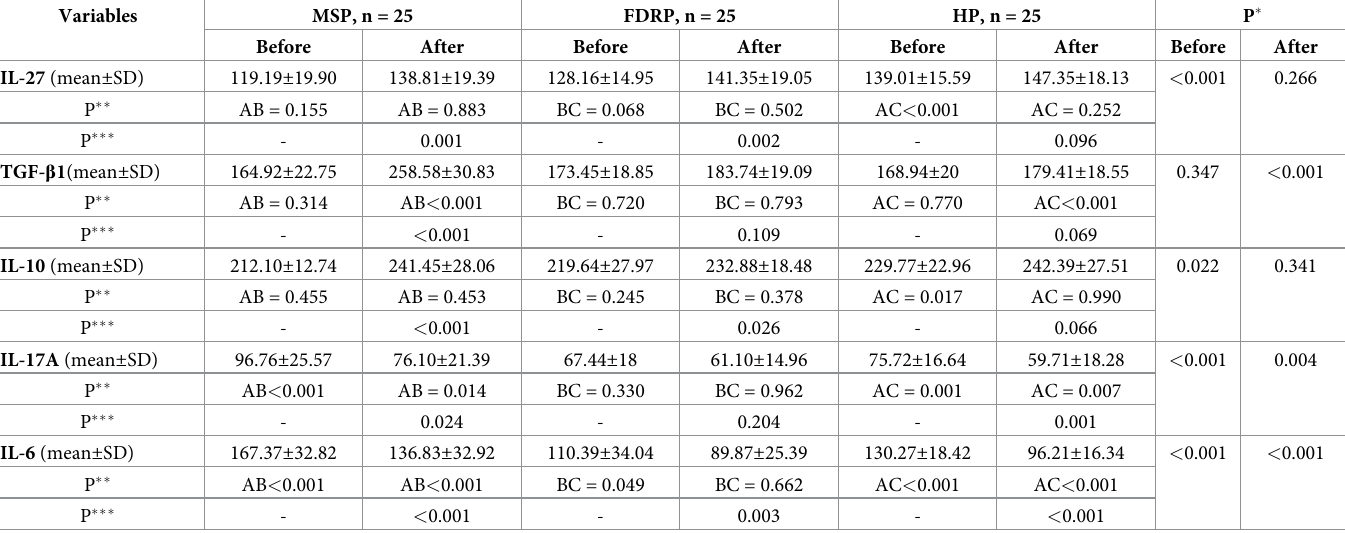
The data are represented as mean ± standard deviation (SD). One-way ANOVA and then, post-hoc Tukey’s test were applied to the analysis of differences between groups. Within-group comparisons of mRNA expression surfaces of IL-27 and TGF- β 1 were also fulfilled by using the paired t-test. Between-group differences, pairwise comparisons (Tukey’s test), and within-group differences were shown by P � , P �� , and P ��� , respectively. Likewise, MSP, FDRP, and HP were represented by A, B, and C. P < 0.05 shows the statistical significance, and the sign † stands for the expression surfaces of cytokines in comparison with the baseline values, according to the ratio formula (2- ΔΔ CT). Abbreviations: ANOVA, analysis of variance; IL, Interleukin; TGF- β 1: transforming growth factor- β ; MSP, Multiple Sclerosis Participants; FDRP, First-Degree Relative Participants; HP, Healthy